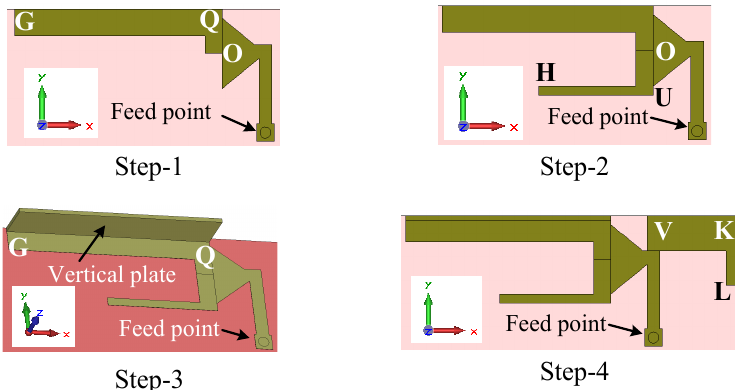
Figure 7. The four steps of the evolution of the dual-band antenna (Ant#2).